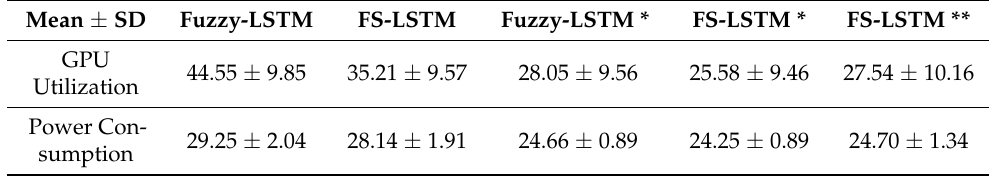
Table 1. The mean ± standard deviation of GPU utilization and power consumption. Fuzzy-LSTM and FS-LSTM networks trained with 32 layers (denoted with *), and a hybrid version of FS-LSTM (denoted with